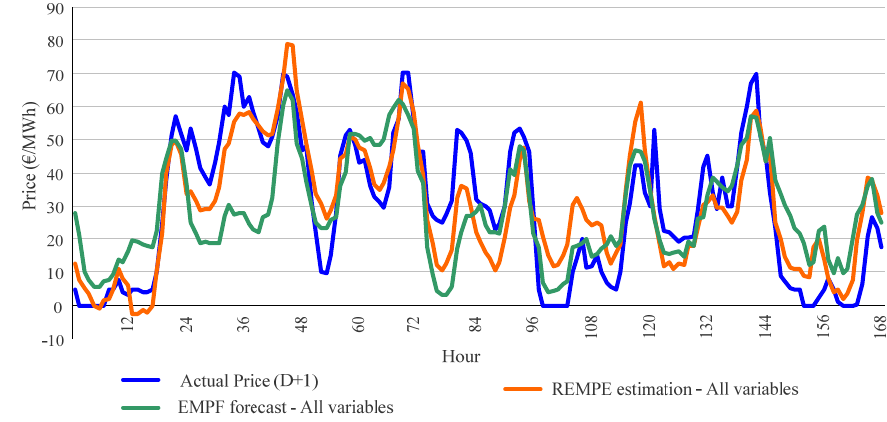
Figure 6. Actual price values, forecast values of the EMPF model, and REMPE estimation values for the week 7 of year 2013.